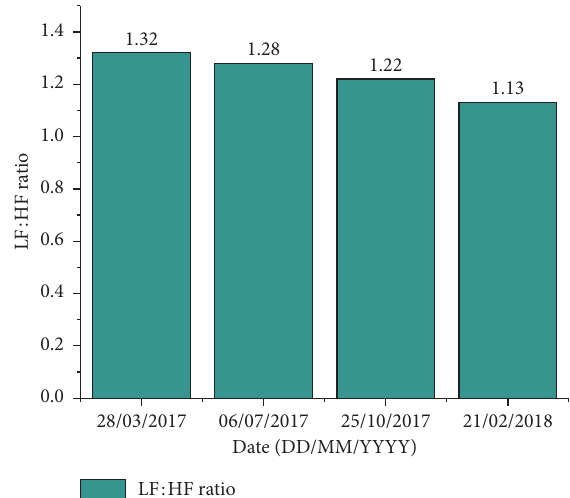
Figure 2: Ratio of low frequency (LF) to high frequency (HF) power (LF :HF) heart rate variability after the patient sustained his two mTBI’s (September and October